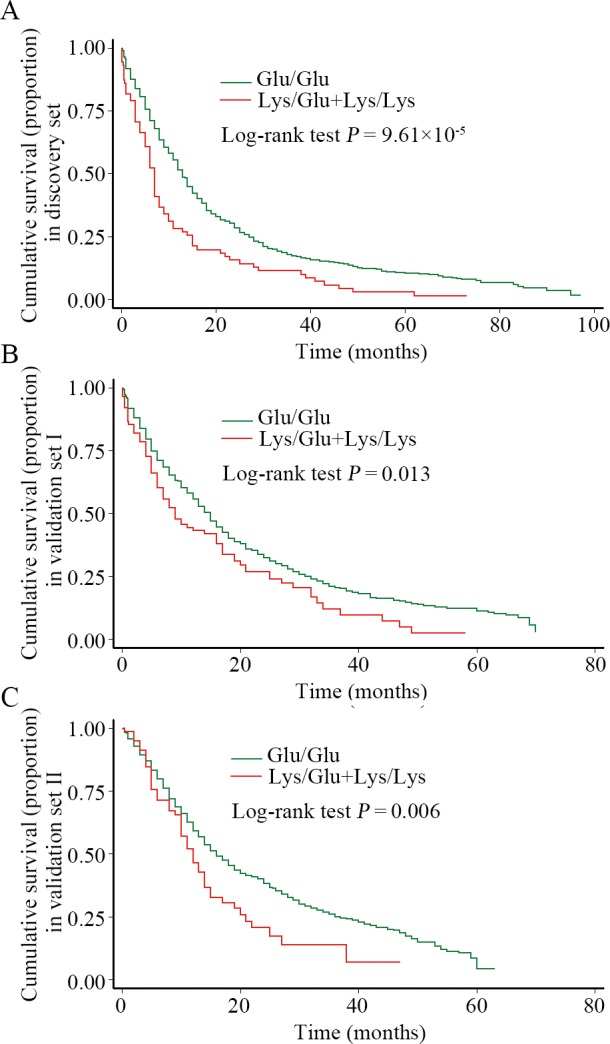
Kaplan-Meier (KM) survival curves for lung cancer patients carrying the different MKK7 p.Glu116Lys genotypes.The P value was calculated by the Log-rank test. (A). KM curves of patients from the discovery set; (B). KM curves of patients from validation set I; (C). KM curves of patients from validation set II.